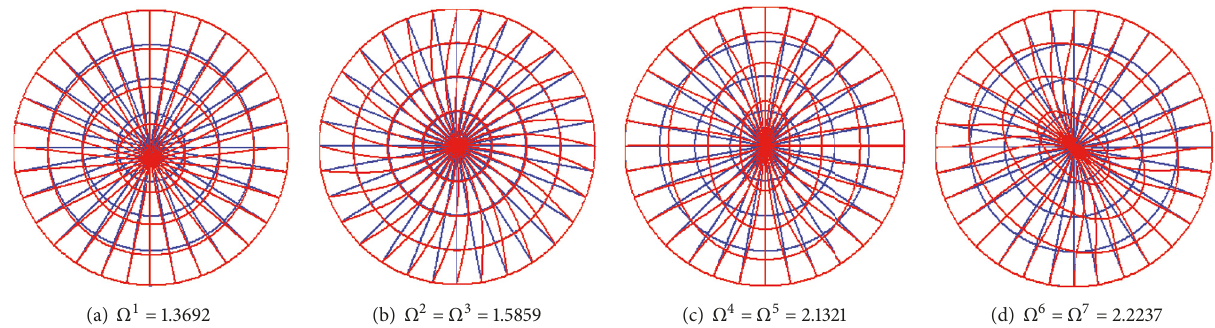
Figure 10: The first four mode shapes of C circular plate with different boundary